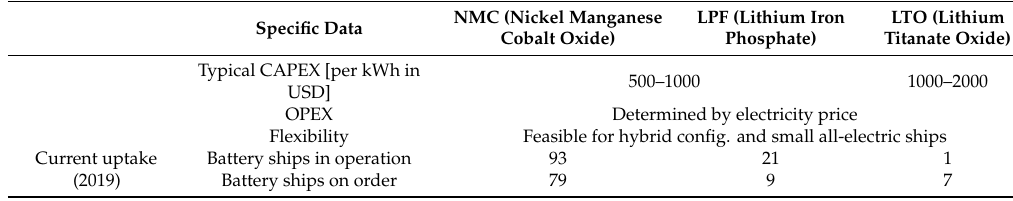
Table 2. Main Economic Characteristics of Lithium-Ion Marine Batteries